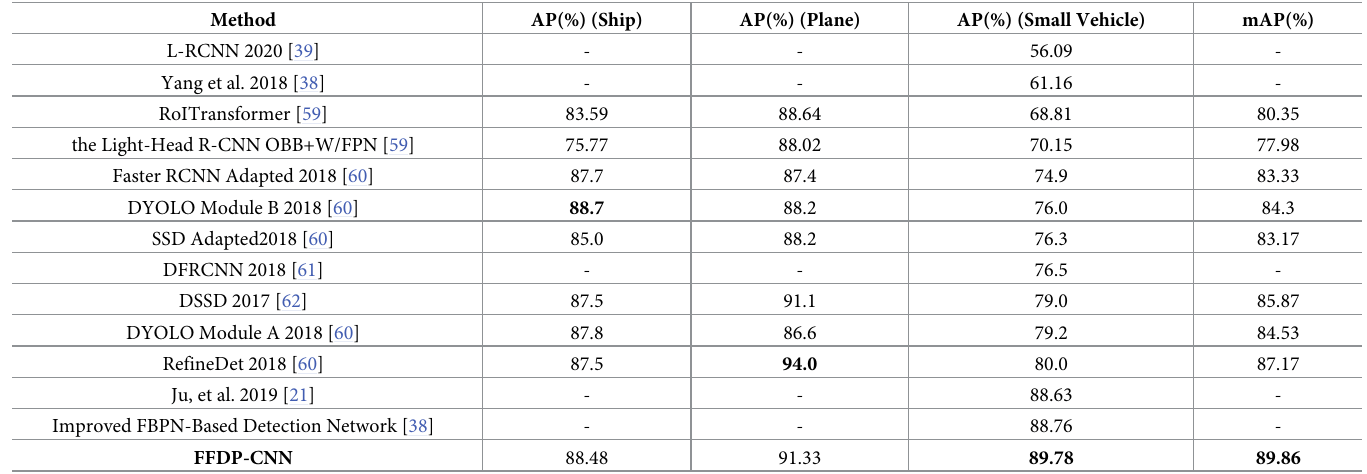
Table 12. Comparison between proposed framework and other methods on